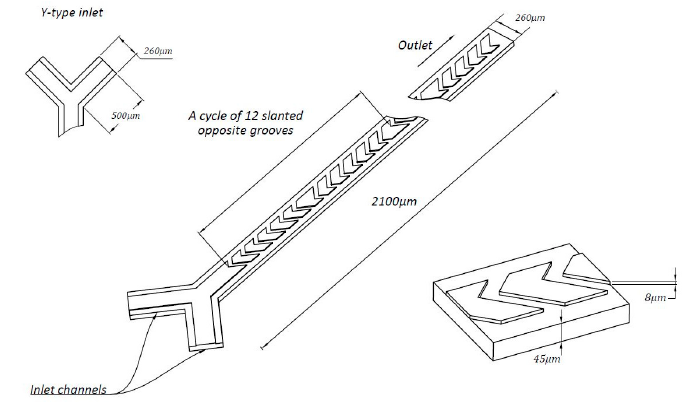
Figure A1. Geometry schematic of the model in micro mixing system and cycled pattern.